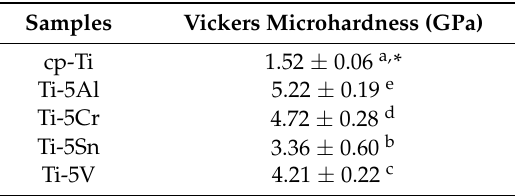
Table 2. Vickers microhardness values of cp-Ti and Ti alloys ( n = 5).